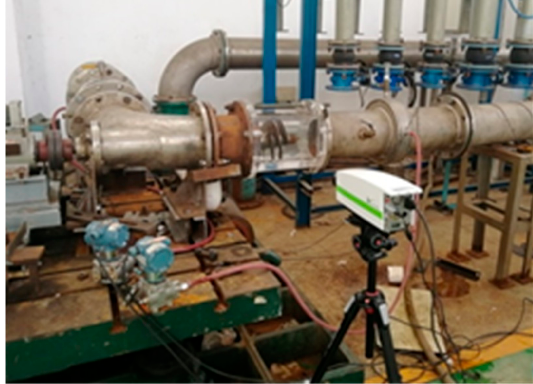
Figure 5. Layout of the experimental device.